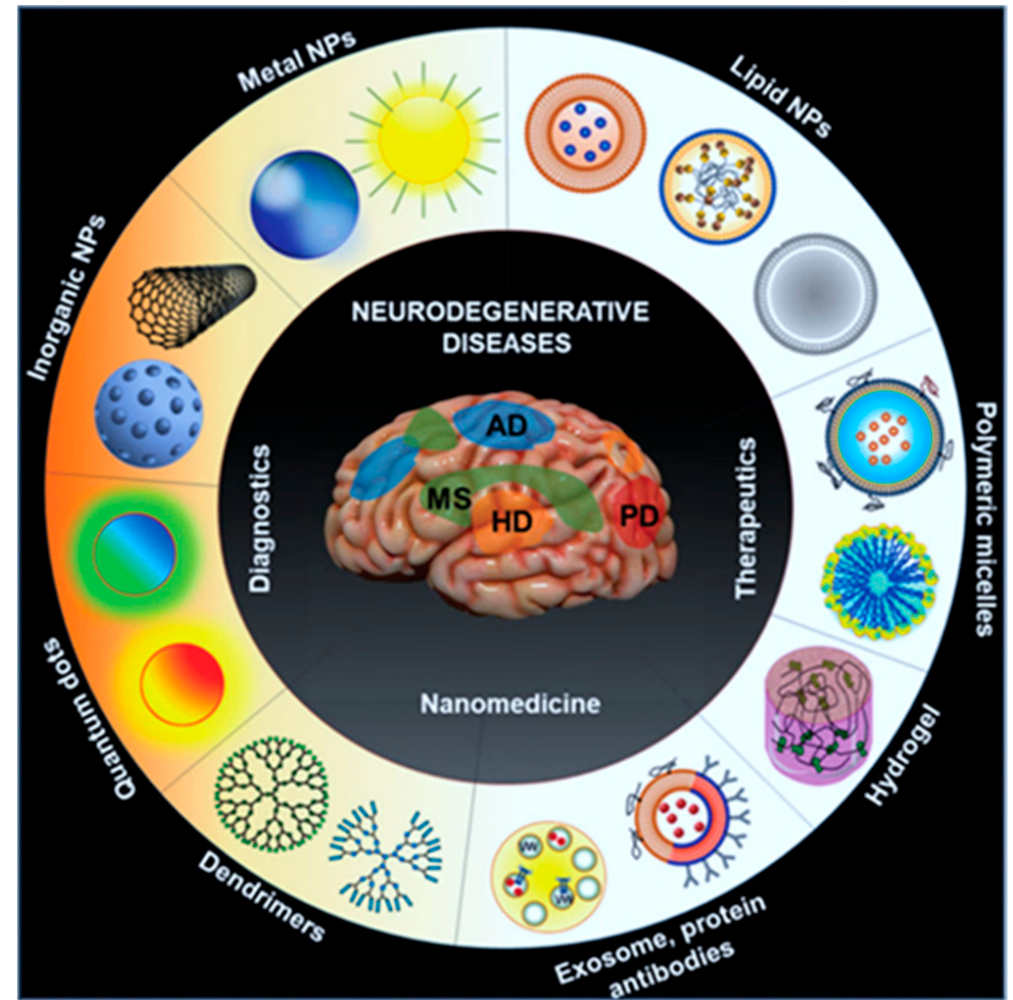
Figure 1. Scheme identifies the emerging different kinds of nanomaterial formulations attempted for the improved drug delivery approaches in neurological diseases. Reprinted with permission from Ref. [8]. Copyright 2021 John Wiley and